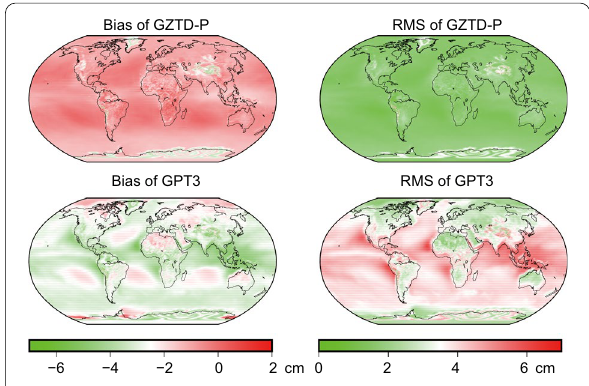
Fig. 5 The biases and RMSs of GZTD-P model and GPT3 model validated with MERRA-2